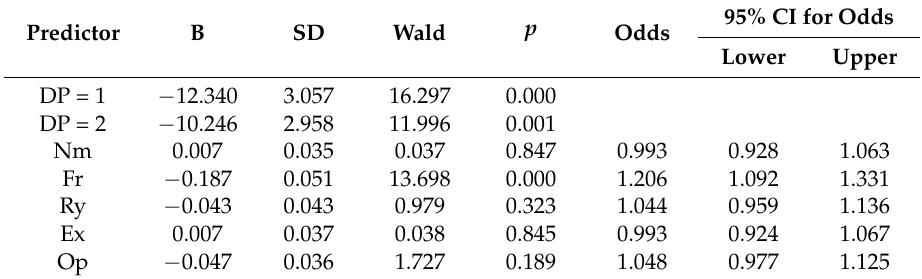
Table 4. Ordinal logistic regression for the depersonalisation model.